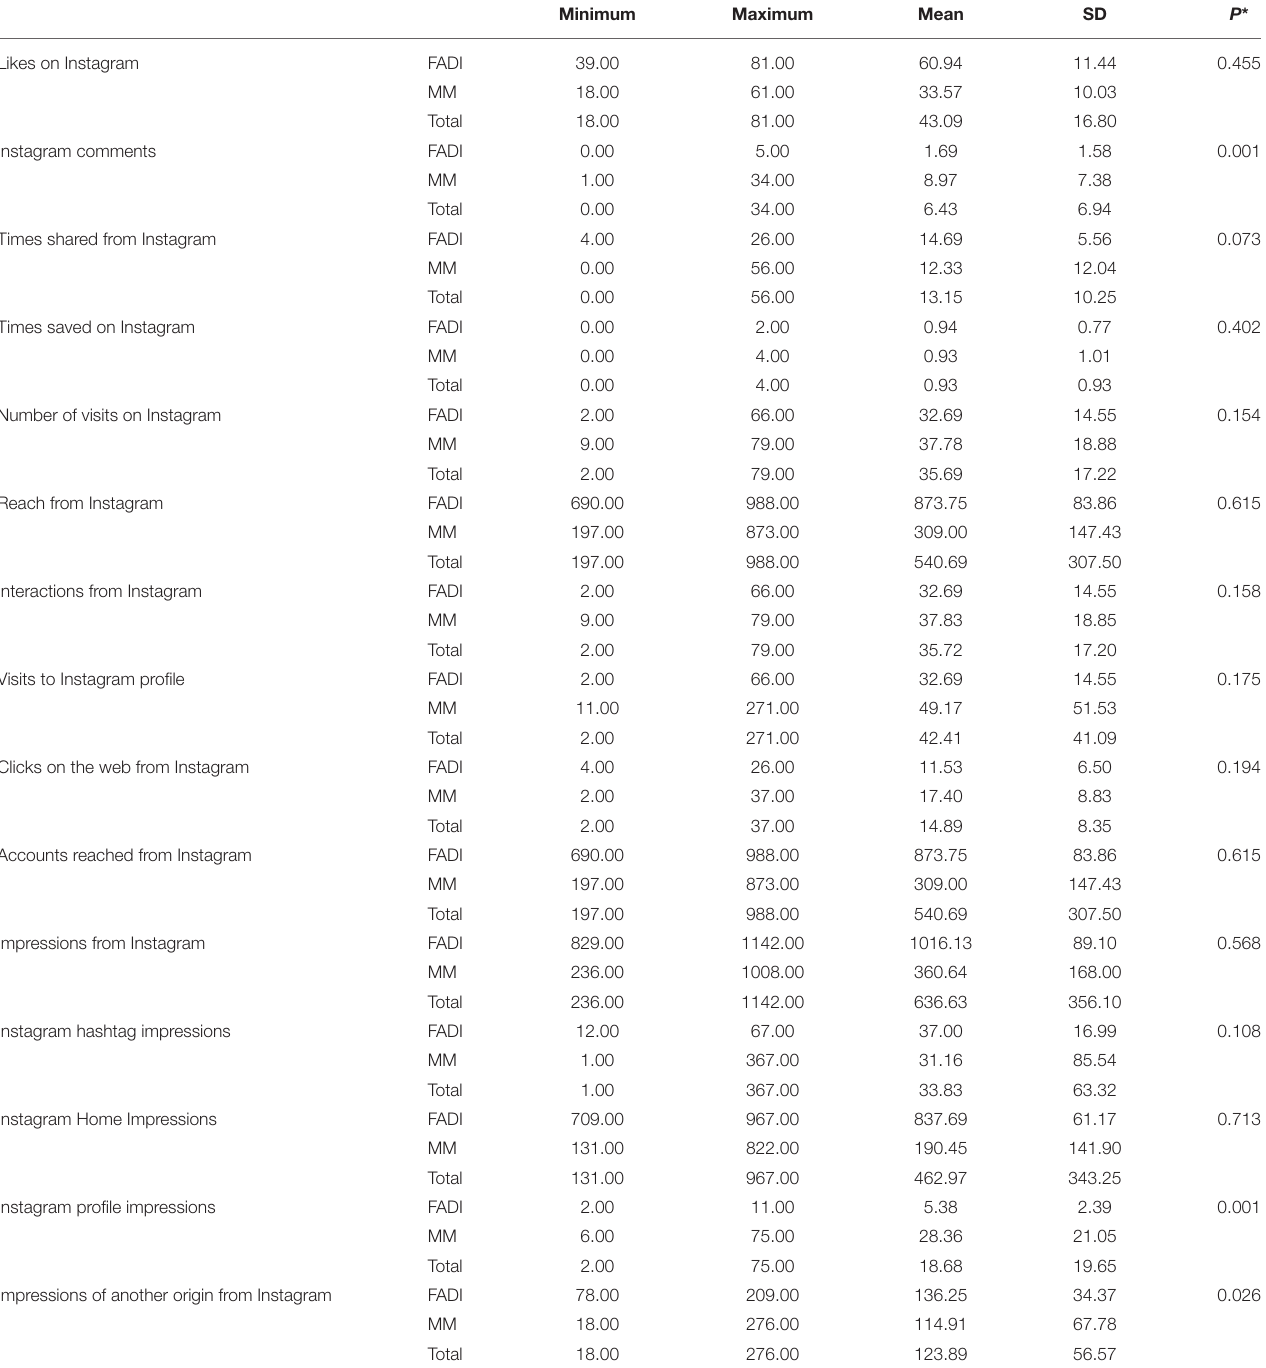
TABLE 7 | Comparison of results of both platforms through Instagram.